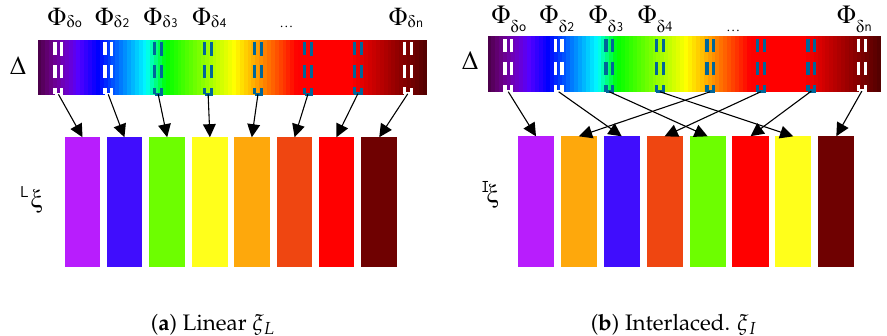
( b ) Interlaced. ξ I